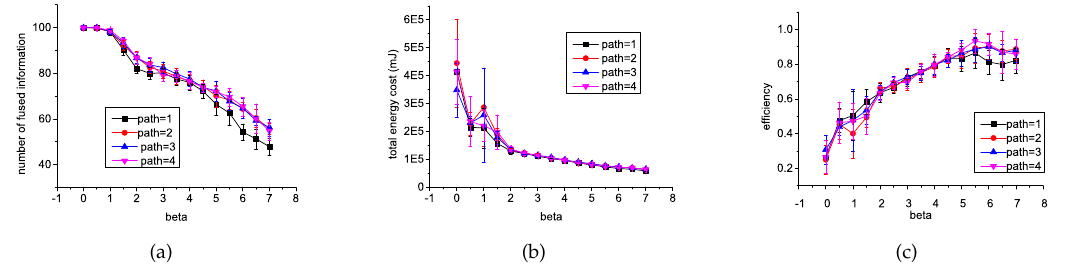
Figure 3. Experimental results with different β and different length of path. ( a ) introduces the comparisons of the number of fused information; ( b ) introduces the comparisons of the energy cost on communication; ( c ) introduces the comparisons of the fusion